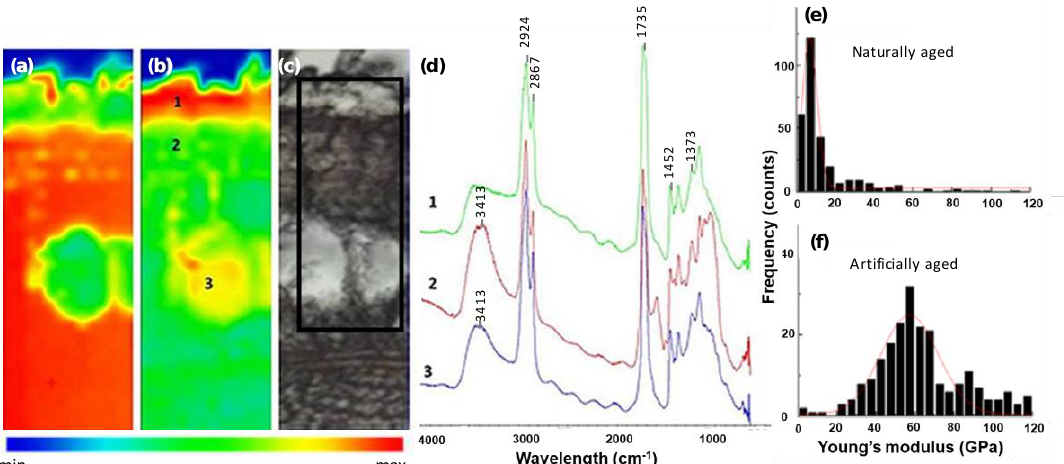
5 of 12 Figure 2. Model systems optical images together with AFM images of samples (1 to 6) before ageing: oil-based (1 and 5); AFM image 1, z scale image = 159.4 nm/Roughness 19.1 nm; AFM image 5, z scale image = 164.5 nm/Roughness 18.2 nm; and spirit-based varnish layers (2, 3, 4, 6); AFM image 2 z scale image = 235.6 nm/Roughness 10.5 nm; AFM image 3, z scale image = 522.6 nm/Roughness 33.6 nm; AFM image 4, z scale image = 823.9 nm/Roughness 18.6 nm; AFM image 6, z scale image = 260.0 nm/Roughness 14.5 nm on top of maple wood over preparation layers of various compositions (Table 1). With regard to the mechanical properties of these samples measured at the nanoscale level, Young’s modulus values were calculated from the measured force dist ance curves